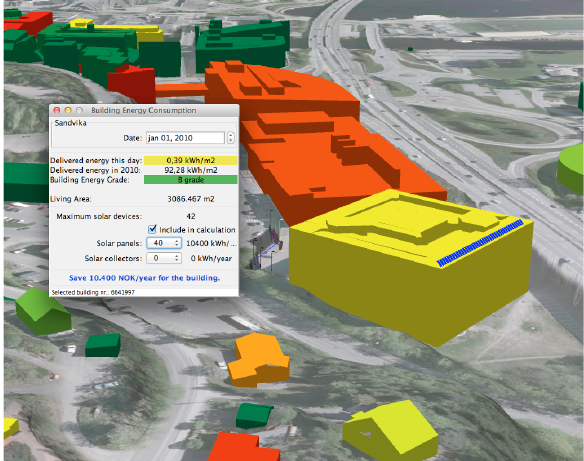
Figure 8. Selected building (yellow) with 40 solar panels placed on the roof (appears here as a blue